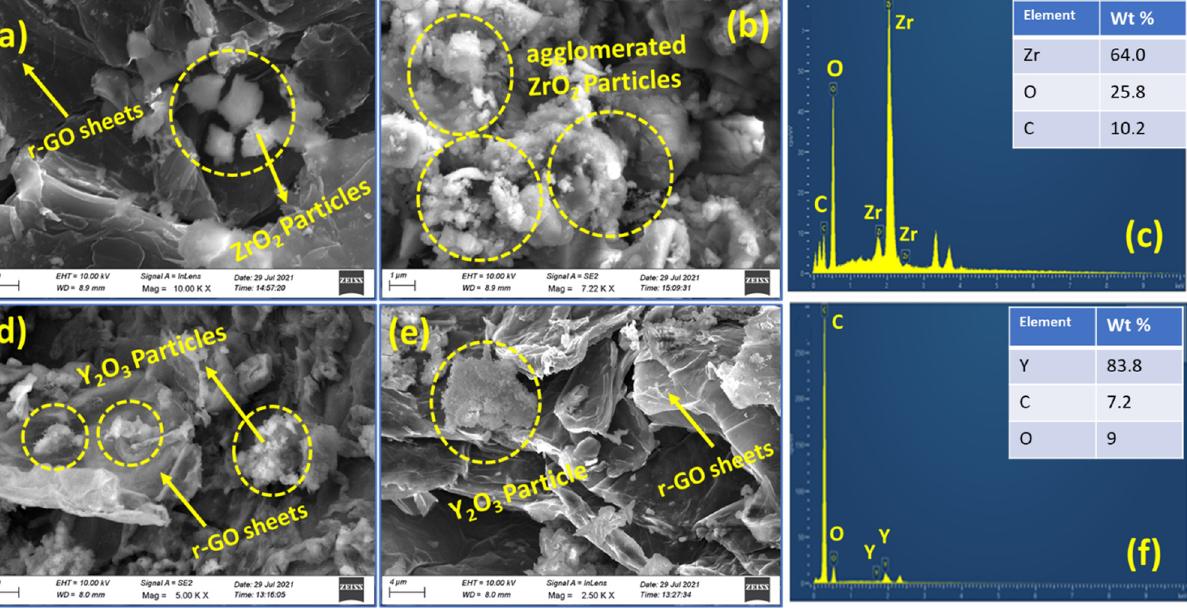
Figure 2. SEM of r-GO-ZrO 2 ( a , b ) and rGO-Y 2 O 3 ( d , e ). EDAX images of ( c ) of r-GO-ZrO 2 and ( f ) r-GO-Y 2 O 3 .